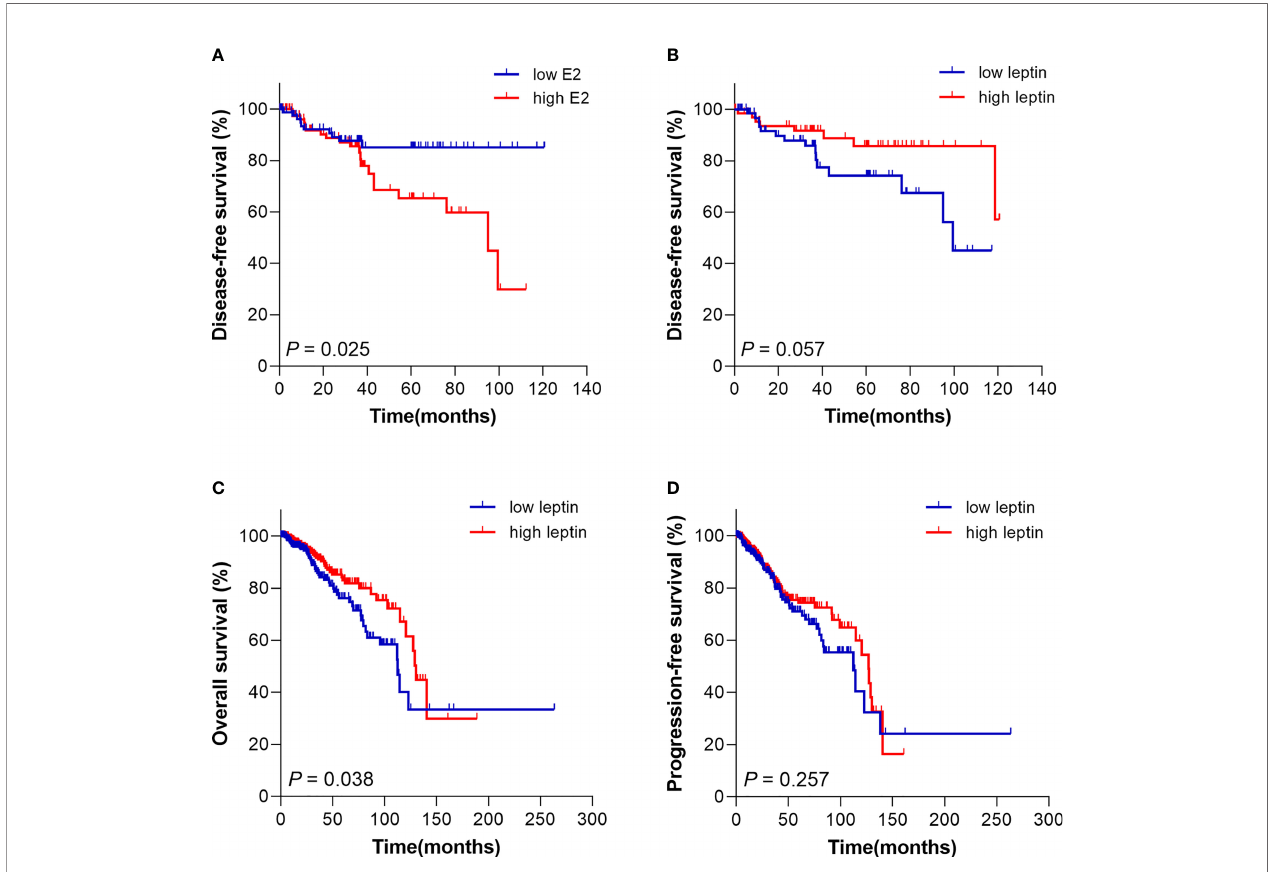
FIGURE 2 | Kaplan Meier survival curve for prognosis analysis of breast cancer patients with different E2 and leptin levels. (A) The disease-free survival of patients with high E2 level was poorer compared with patients with low E2 level. (B) High leptin level trended to be a protective signal for disease-free survival of patients. (C) Patients from TCGA database with high leptin level had superior overall survival than patients with low leptin level. (D) The progression-free survival of patients from TCGA database with different leptin level presented no signi fi cant